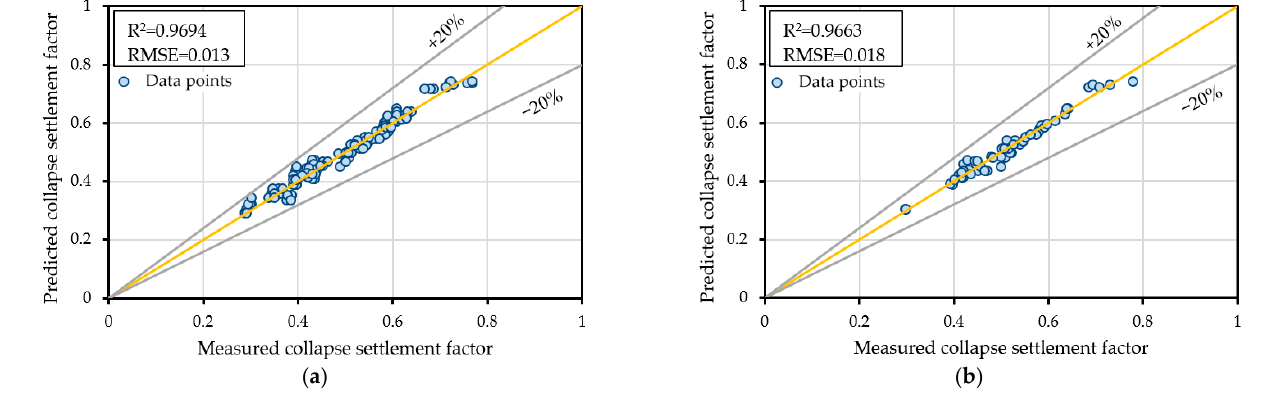
Figure 13. Comparing the results of the predicted and measured coefficient of stress release based on the sinusoidal function. ( a ) Training data, ( b ) Testing data.